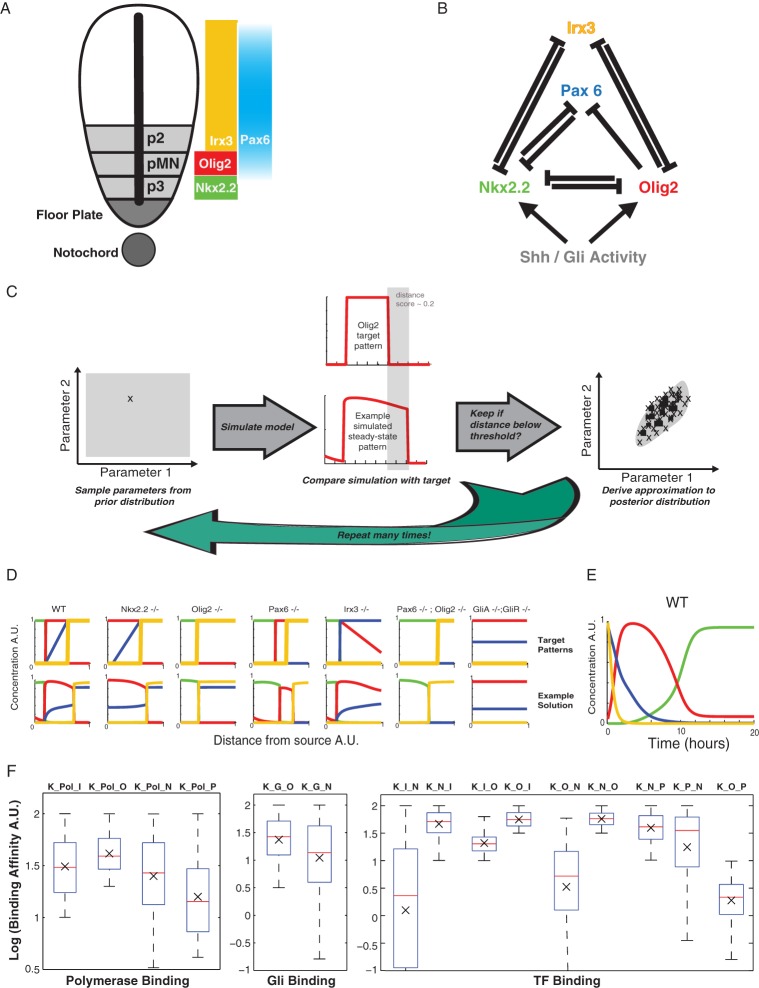
Approximate Bayesian computation (ABC) of parameter distributions for a gene network model. (A) In the neural tube, the notochord and floor plate provide a source of Shh. This gradient acts through Gli proteins to produce a spatial pattern of distinct progenitor domains in the ventral region (the three ventralmost domains are shown: p2, pMN, p3). Each domain is characterised by the expression of different sets of TFs; the spatial distribution of four of these (Nkx2.2, Olig2, Irx3 and Pax6) is illustrated. (B) Nkx2.2, Olig2, Irx3 and Pax6 form a cross-repressive network with the regulatory links indicated in the diagram. Pax6 and Irx3 are expressed in the absence of any Shh signal. Nkx2.2 and Olig2 are regulated by Gli activity. (C) In ABC, parameter sets are drawn from a multi-dimensional prior distribution. We illustrate the idea for a model with just two parameters. The set of parameters drawn is then used in a model simulation – in this case a pattern of each of the four genes was derived by simulating the dynamical model described in Eq. 9 to steady state. The pattern that results from the simulation is scored against a target output (see Materials and Methods for details); in this example, roughly 20% of the pattern of one of the genes (highlighted in grey) does not match the target, giving a distance score of 0.2. Parameter sets that score a sufficiently low distance are kept, the rest discarded. The posterior distribution is approximated from the distribution of the retained parameter sets. (D) The sets of target patterns for the WT and six different mutants are shown in the top row. The x-axis represents the ventral-dorsal position in the neural tube extending away from the morphogen source. The y-axis represents the protein concentration for each of the four TFs (colour-coded according to A). The bottom row shows a typical example of a simulated set of patterns using a set of parameters derived from the Bayesian analysis. The patterns represent the steady-state level of protein expression after 100 h of simulation at each position in the gradient. The parameters in this example are: α=β=2, cAP=10, KG_O=18.0, KG_N=37.3, KP_N=4.8, KP_O=47.8, KP_Pax=4.8, KP_I=23.4, [P]=0.8, KN_Pax=26.7, KO_Pax=1.9, KN_O=60.6, KO_N=27.1, KPax_N=4.8, KO_I=58.8, KN_I=76.2, KI_O=28.4, KI_N=47.1. The mutants were simulated by setting the relevant production rate to zero. For the Gli mutants, Gli binding was set to zero. In each case, the target pattern is approximately reproduced by the simulated pattern. (E) The temporal dynamics of the model (using the example parameter set in D) at x=0.1 (a position that will express Nkx2.2 in the WT) are shown. The zero time point represents the start of the Shh signal (after the system has settled to a steady state). The figure shows the sequential expression of the different TFs consistent with in vivo data (Balaskas et al., 2012). (F) The marginal (single parameter) posterior distributions for each of the binding affinities derived in the Bayesian analysis are represented as box plots. The boxes show the median, lower and upper quartile ranges. The whiskers encompass ∼99% of the distribution. The black cross shows the mean value.